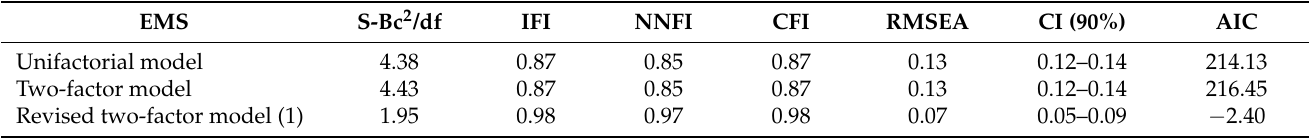
Table 2. Goodness-of-fit indices for ML models of EMS